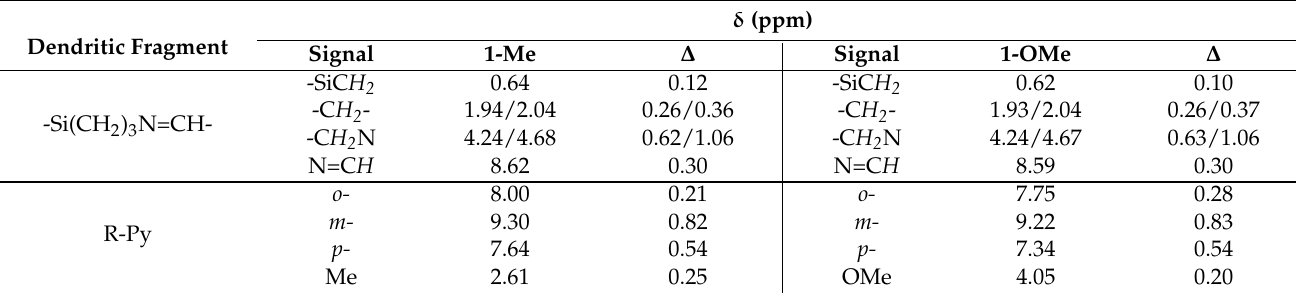
Table 1. 1 H-NMR shifts for selected signals in the new Ru(II) metallodendrimers and increase compared to the precursor dendrimers I and II [16].